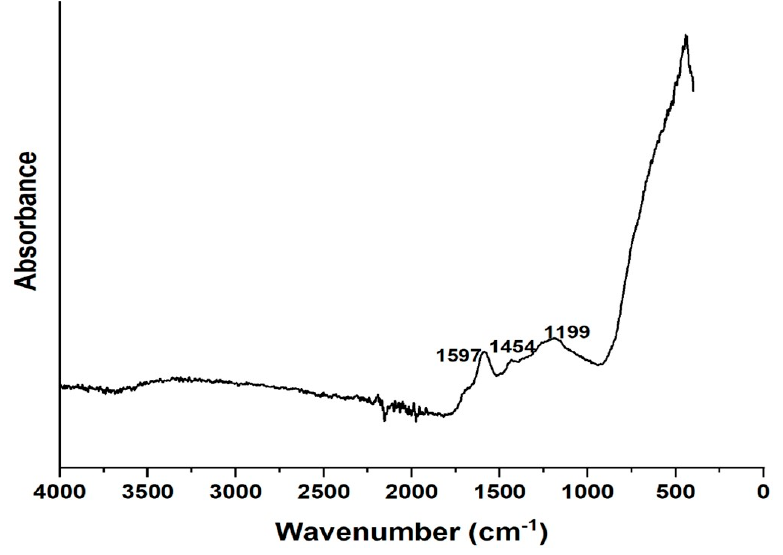
Figure 11. FTIR of HCP25 after adsorption .